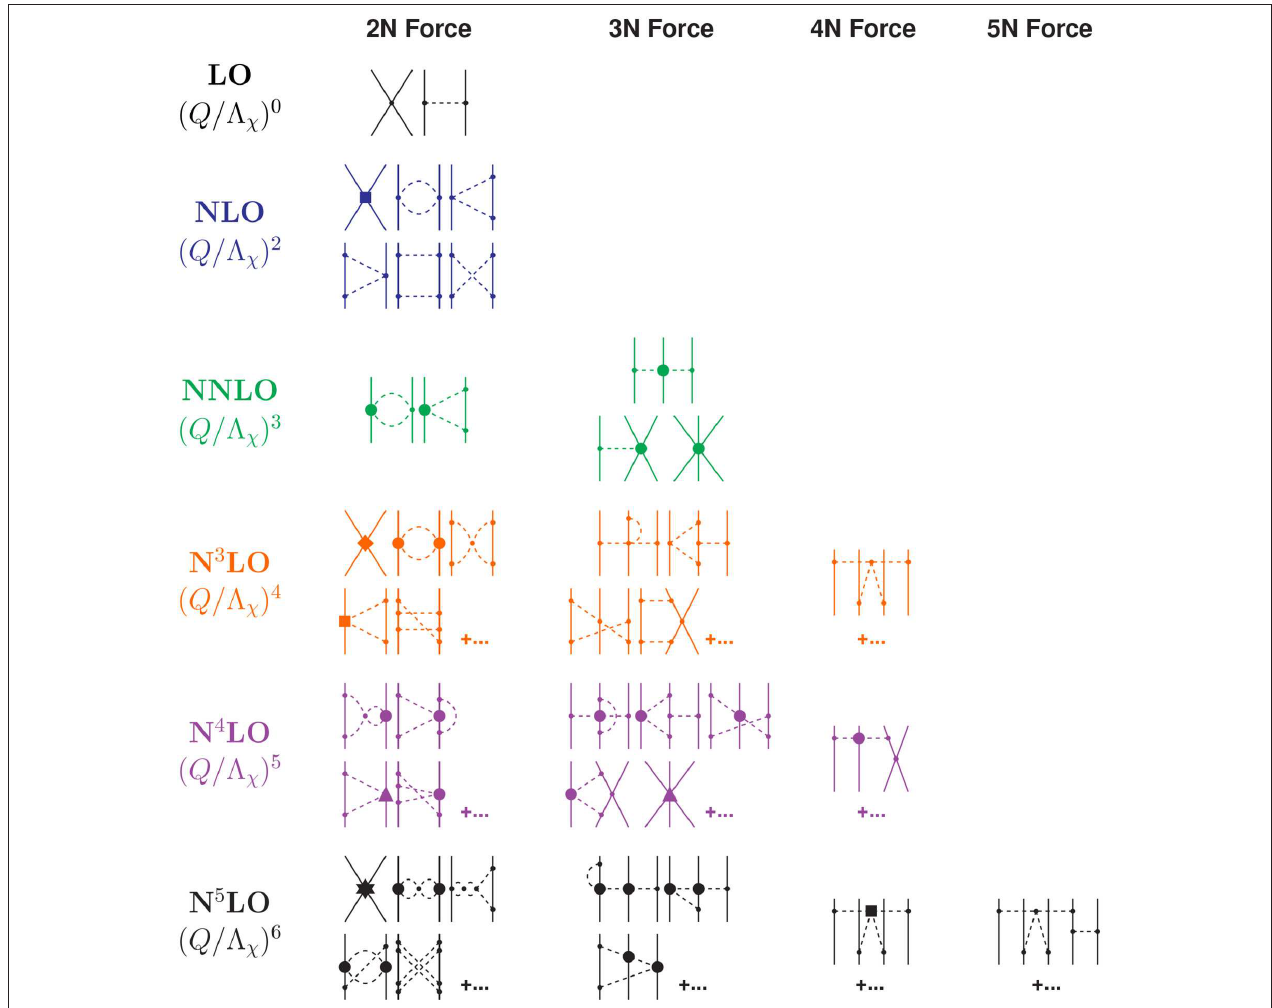
FIGURE 1 | Hierarchy of nuclear forces up to N 5 LO or sixth order of the chiral expansion. Only some representative diagrams are included. Small dots, large solid dots, solid squares, triangles, diamonds, and stars denote vertexes of index 1 i [ 37], copyright (2017) by the American Physical